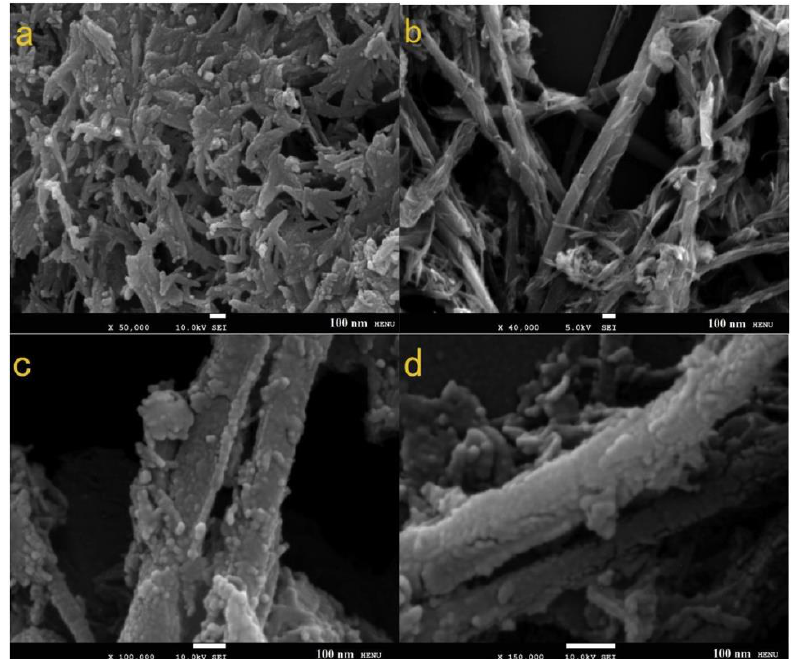
Figure 8. SEM micrographs for ( a ) VS 2 , ( b , c, and d ) VS 2 /CNT. ( c and d ) Enlarged display of a VS 2 /CNT. Reproduced with permission from Reference [40], Elsevier 2017.